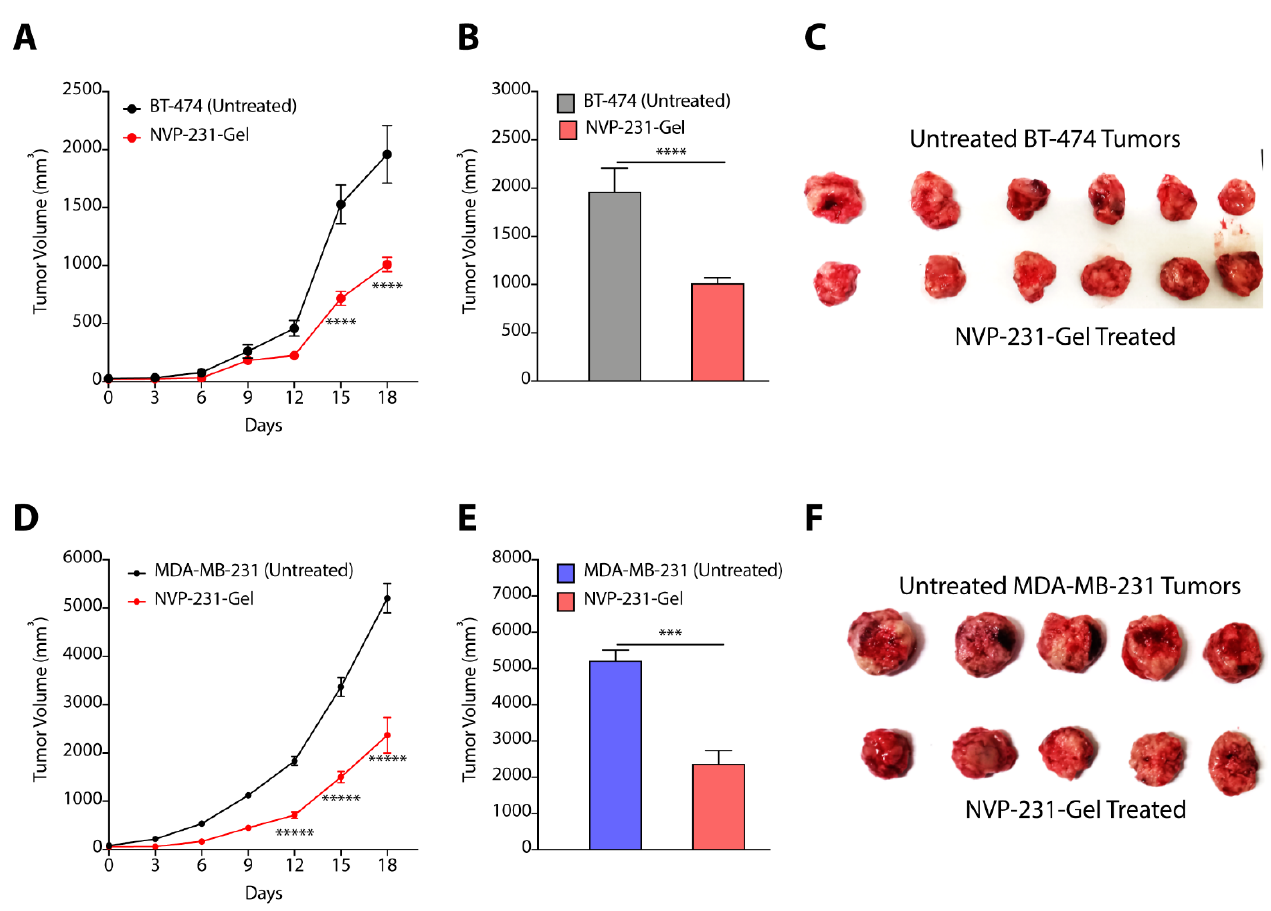
Figure 8. ( A – C ) Tumor growth kinetics ( A ), final day tumor volume ( B ), and pictures of excised tumors ( C ) showing the effect of NVP-231-Gel in BT-474 tumors. ( D – F ) Tumor growth kinetics ( D ), final day tumor volume ( E ), and pictures of excised tumors ( F ) showing the effect of NVP-231-Gel on MDA-MB-231 tumors. Data are presented as mean ± SEM ( n = 5/6), and were analyzed using two-way ANOVA for ( A , D ), and using unpaired student’s t -test for ( B , E ). *** p < 0.001, **** p < 0.0001, ***** p <